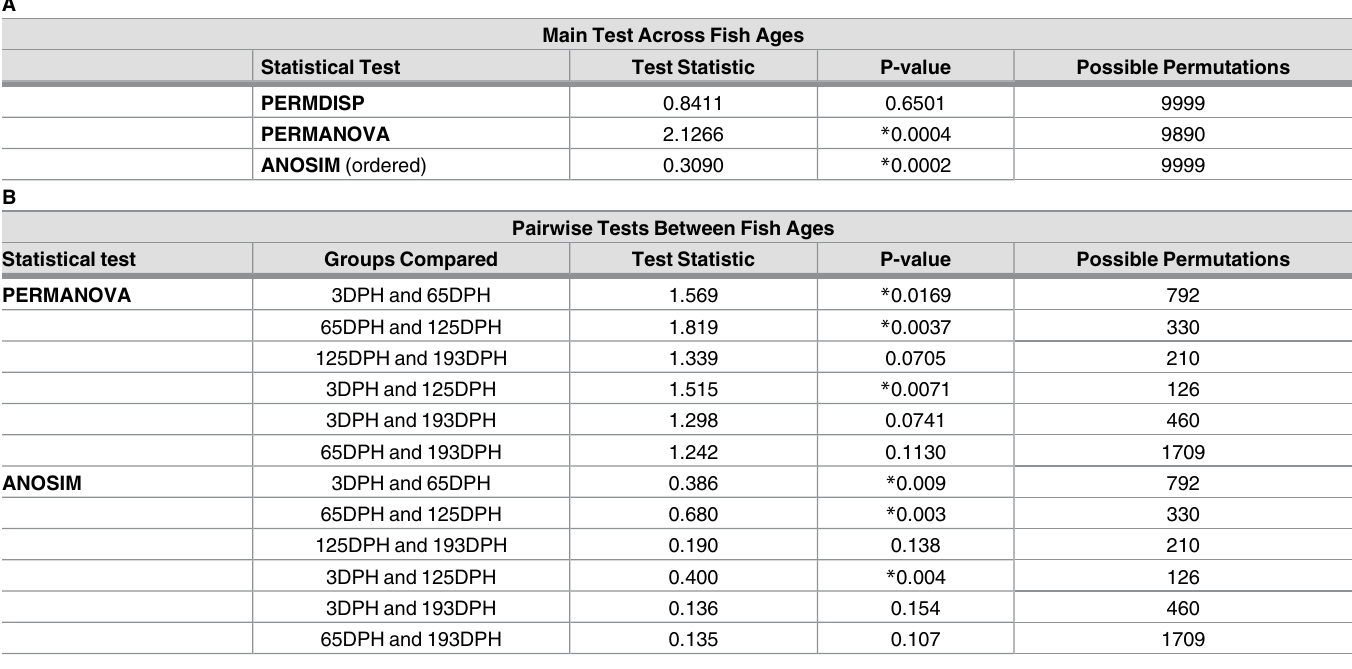
Table 2. Main (A) and pairwise test results (B) of non-parametric permutation-based multivariate statistical analysis of unweighted UniFrac beta diversity of the intestinal microbiota of channel catfish across age (days post hatch; DPH). All statistical tests were conductedusing a fixed factor